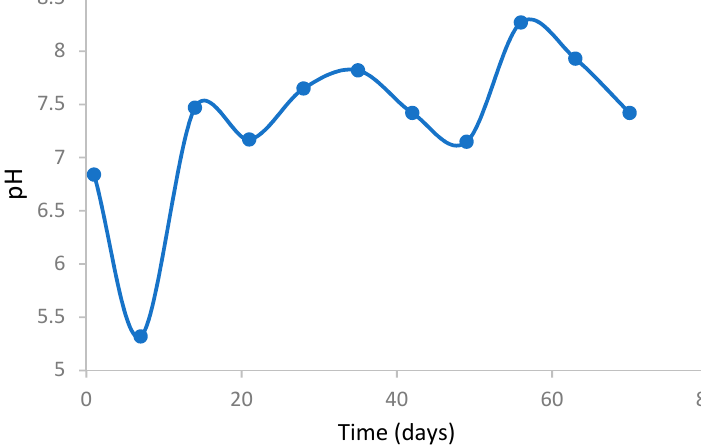
Figure 6. pH variations during the composing process in waste mass.